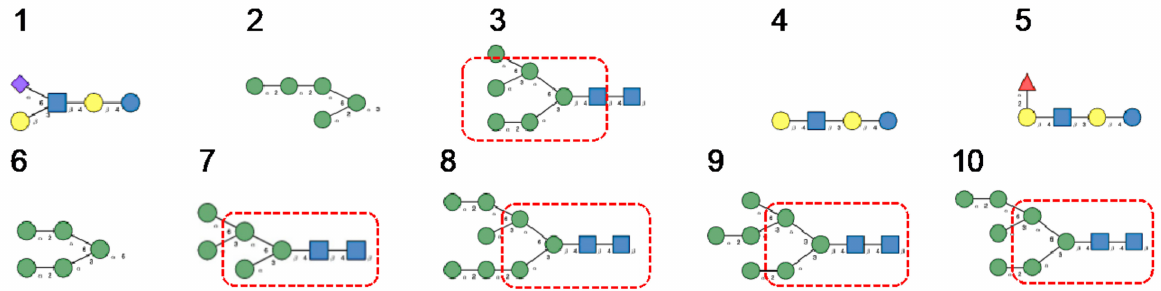
Figure 15. Glycans recognized by TbCVN in glycan array experiments, arranged from 1 to 10 in decreasing order of